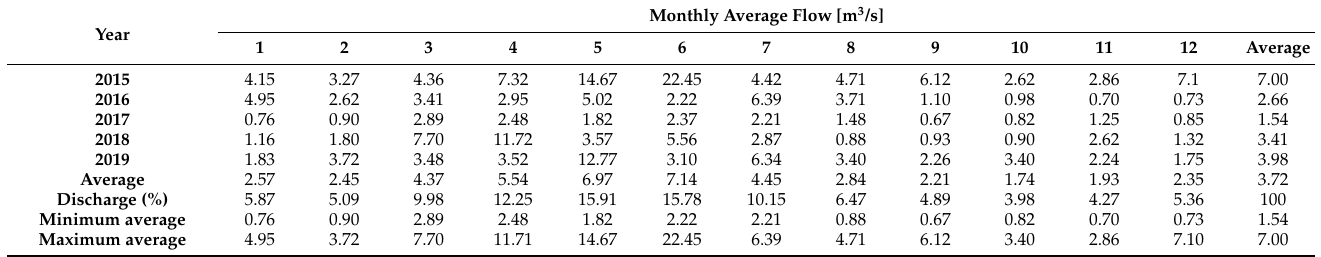
Table 2. Average flow rates of the Torysa river in the Sabinov hydrological station (8770).